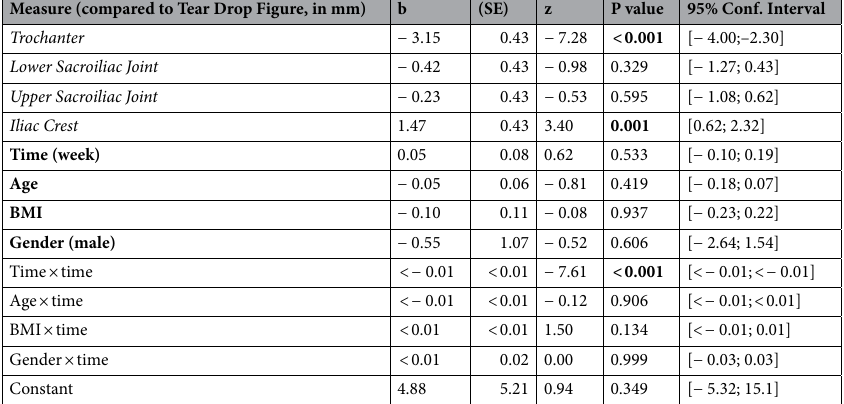
Table 3. Linear mixed effects on the course of leg length discrepancy (n = 99). Coefficients (b), standard errors (SE), z− values, p− values, and 95% confidence intervals given. BMI body mass index, SE standard error, LLD leg length